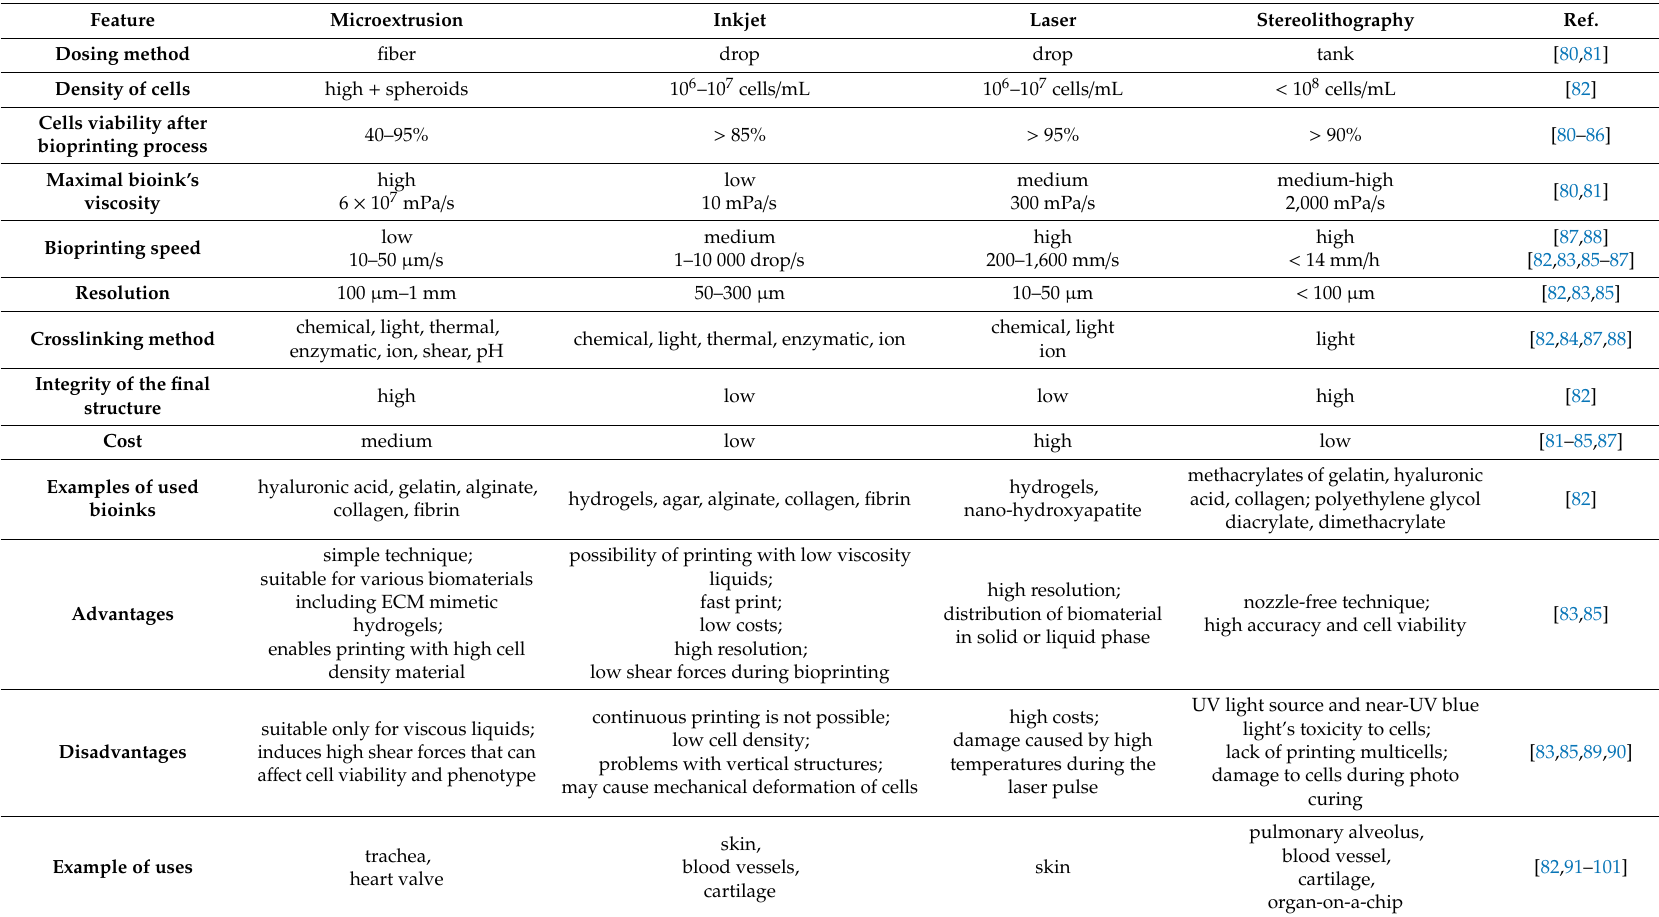
Table 1. Comparison of commonly used 3D bioprinting methods. ECM: extracellular